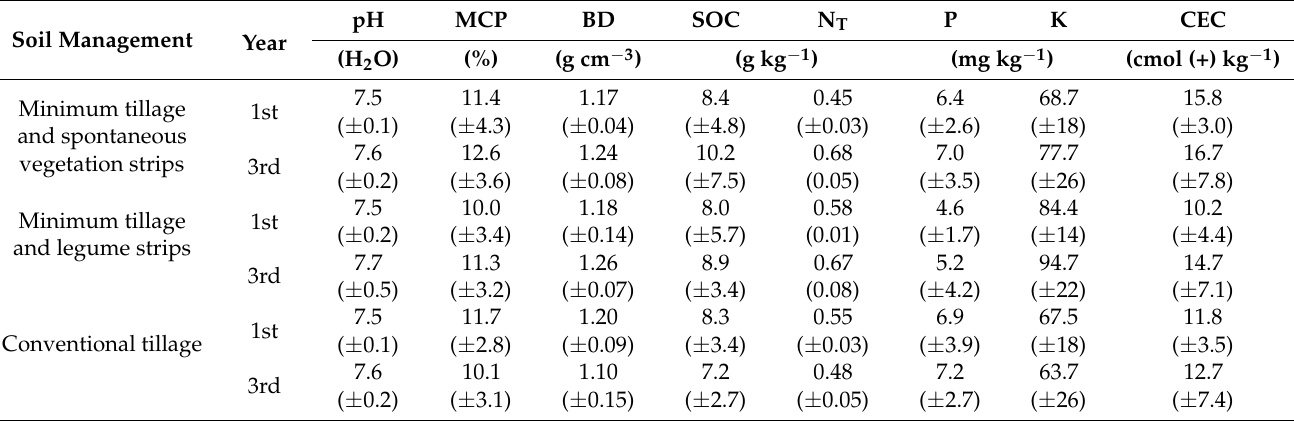
Table 3. Effect of CA practices on soil physico-chemical parameters in olive orchards throughout 3 year monitoring period (SE